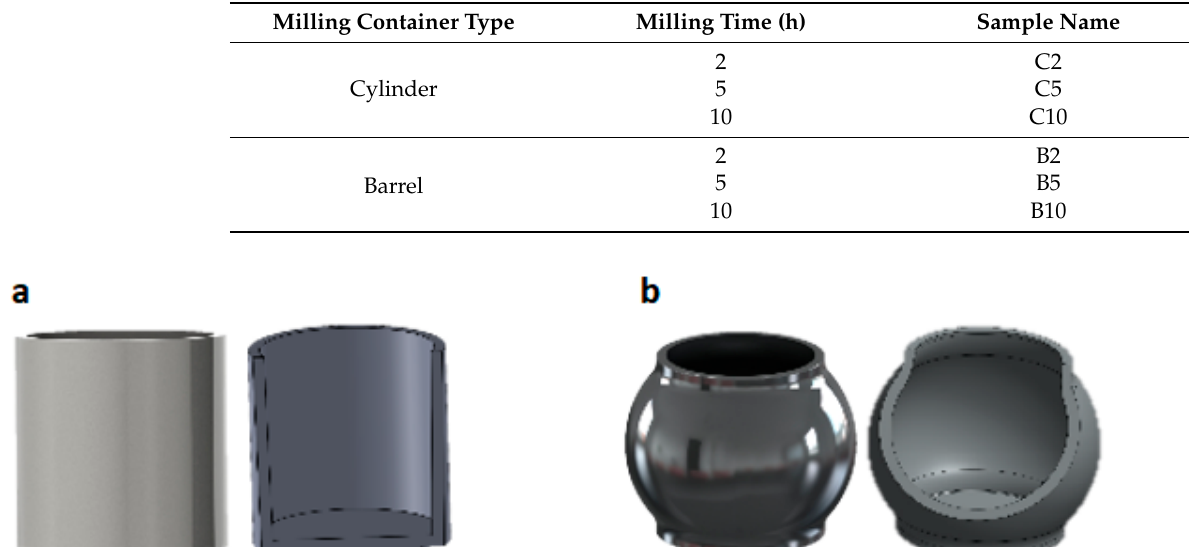
Table 1. Alloy samples with different milling container types and times.